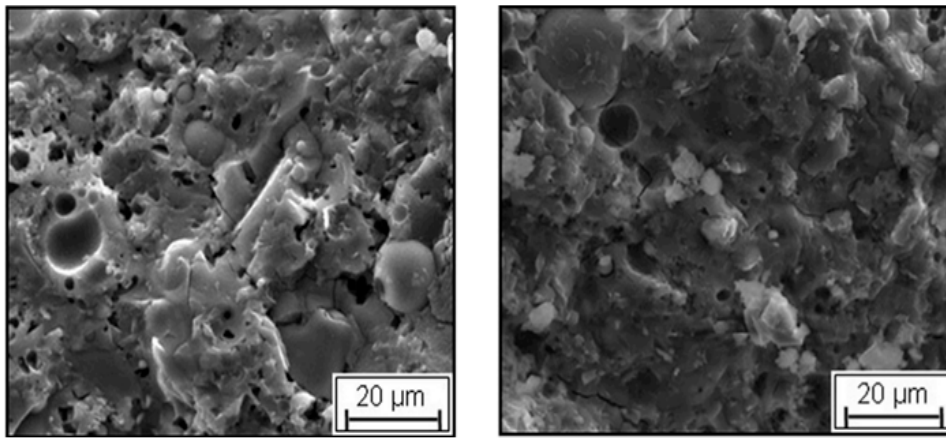
Figure 26. SEM analysis. ( a ) Temperature cured sample; ( b ) ambient temperature cured samples [134].